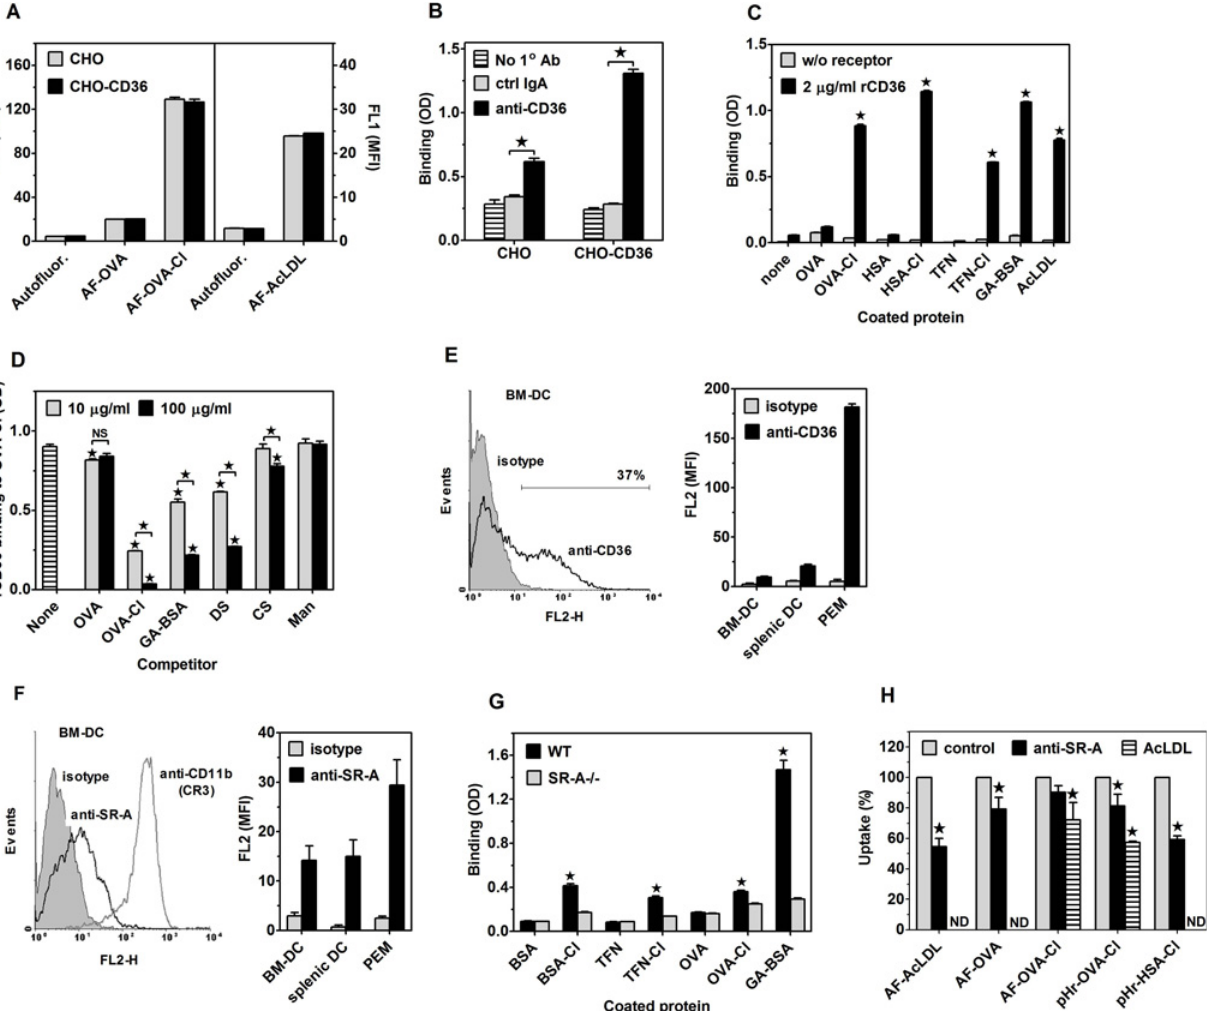
Fig 7. Roles of SR CD36 (A-E) and SR-A (G-I) as receptors for HOCl-modified proteins. ( A ) Uptake of fluorescently-labelled proteins by CHO cells transfected with human CD36 as compared to non-transfected cells. ( B ) Binding of anti-CD36 mAb and control mouse IgA to CD36-transfected and non- transfected CHO cells, determined by cellular ELISA. ( C ) Binding of rCD36 to plate-adsorbed proteins. ( D ) Effects of 10 or 100 μ g/ml of indicated, soluble ligands on rCD36 binding to plate-adsorbed OVA-Cl. ( E ) Binding of polyclonal anti-mouse CD36 Ab and control goat IgG to BM-DC, splenic DC and PEM. A representative histogram of Ab binding to BM-DC is displayed on the left graph. ( F ) Binding of anti-mouse SR-A mAb and control rat IgG2b to BM-DC, splenic DC and PEM. A representative histogram of Ab binding to BM-DC is shown on the left graph. ( G ) Binding of SR-A present in lysates of PEM to plate- adsorbed proteins. ( H ) Effects of anti-SR-A 2F8 mAb and AcLDL on the uptake of fluorescently-labelled proteins by BM-DC. Shown are results of single experiments, each representative of at least 3 similar experiments performed (A-D, G, H) or averages +SEM from 4 – 6 independent experiments (E, F). The data were analysed with the unpaired (A-C, G) or one-sample (H) Student ’ s t-test or with ANOVA, followed by the Tukey-Kramer post-test (D). * , p < 0.05; ND, not